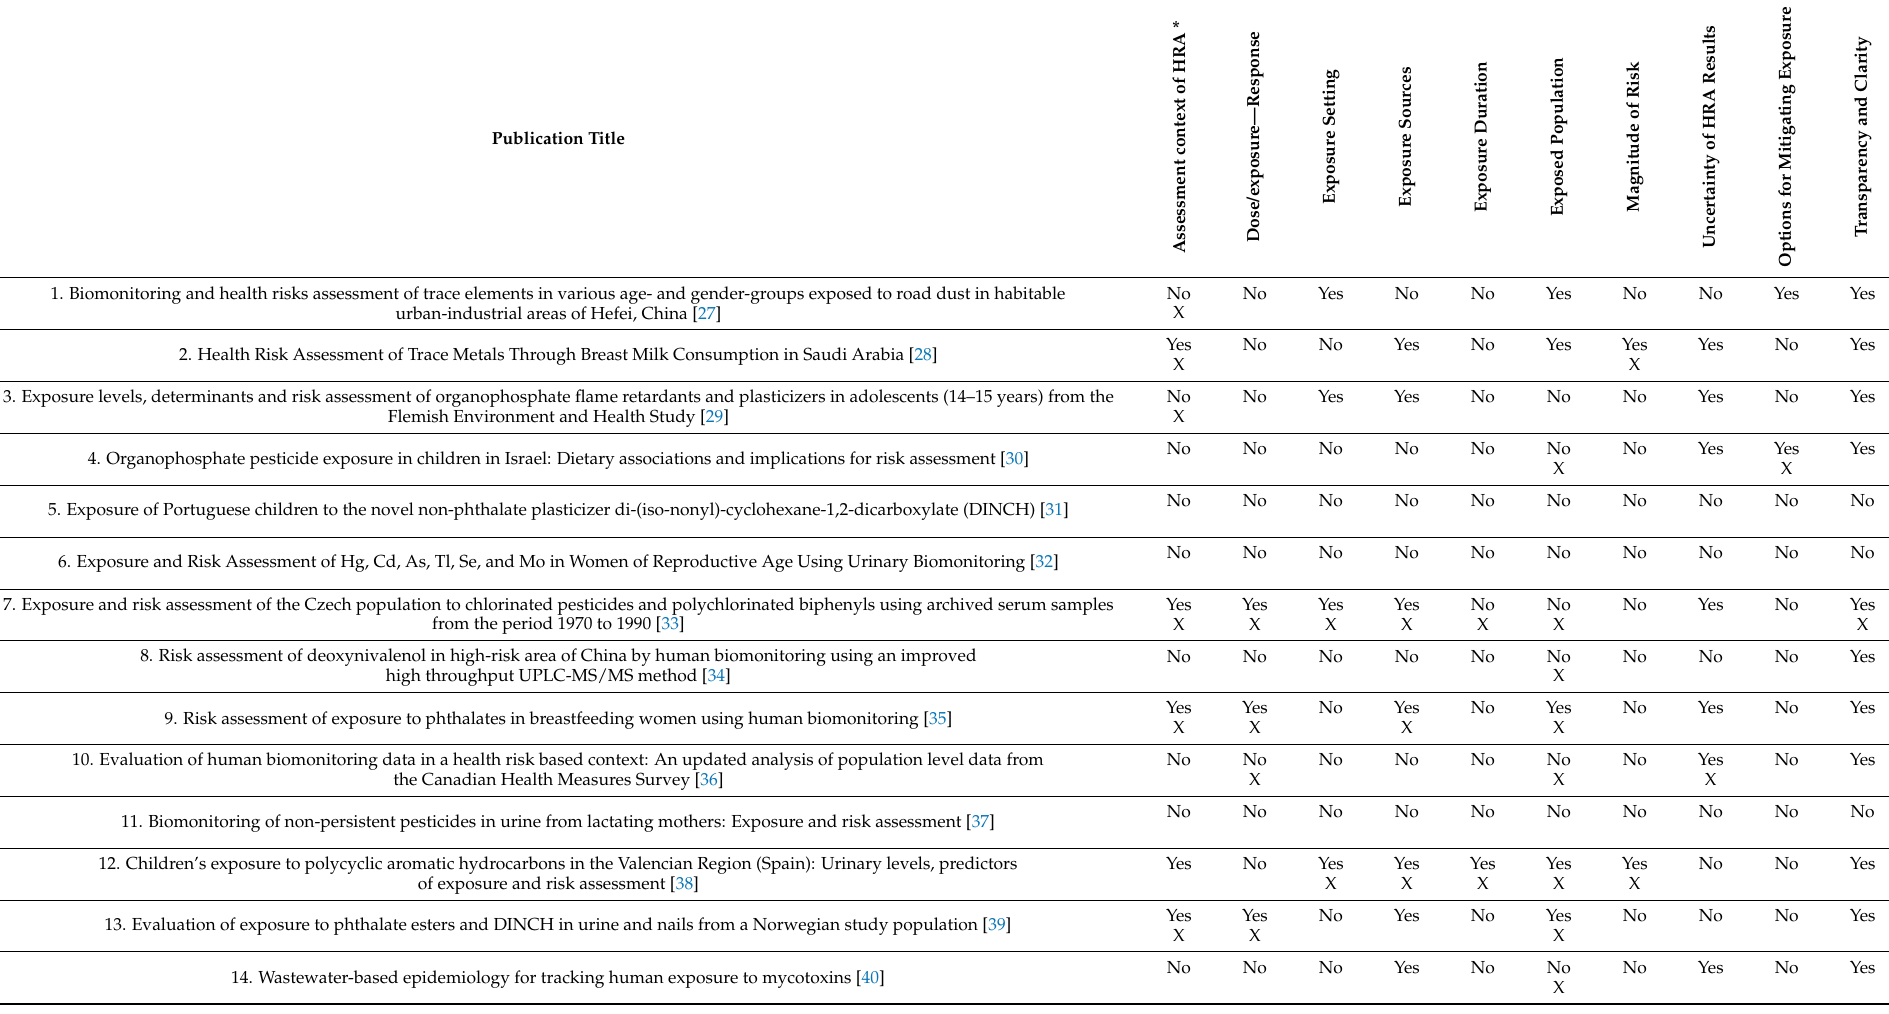
Table 2. Clarity of HRA elements (Yes or No) and the use of human biomonitoring in specific HRA elements (marked with